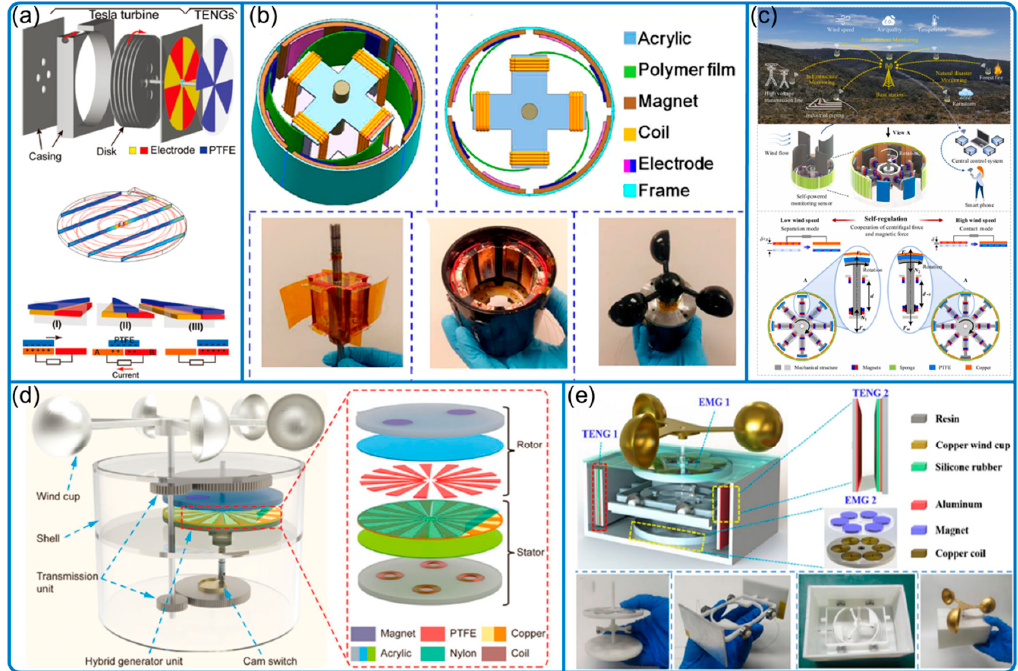
Figure 4. Conventional wind speed sensing with performance enhancement features. ( a ) Bladeless turbine structure. Reproduced with permission. Copyright 2018, Wiley Online Library [22]. ( b ) Ultra-low friction system. Reproduced with permission. Copyright 2018, American Chemical Society [24]. ( c ) Wind-speed-dependent self-regulation strategy. Reproduced with permission. Copyright 2022, Elsevier [26]. ( d ) Travel-controlled approach for high durability. Reproduced with permission. Copyright 2022, Wiley Online Library [25]. ( e ) Rotational to linear motion conversion. Reproduced with permission. Copyright 2020, Elsevier [23].